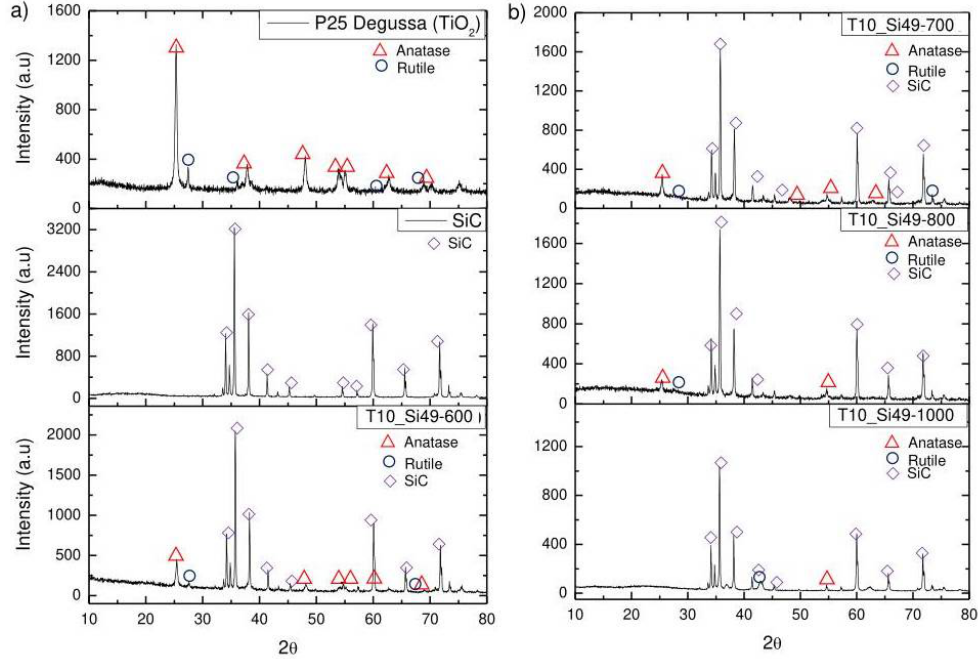
Figure 2. XRD analysis for the samples: ( a ) P25 Degussa (TiO 2 powder), SiC powder and sample T10_Si49-600; ( b ) sample T10_Si49 pyrolyzed at different temperatures (700–1000 °C).